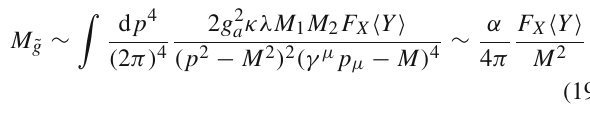
4 Bypassing the no-go theorem with explicit messenger mass terms